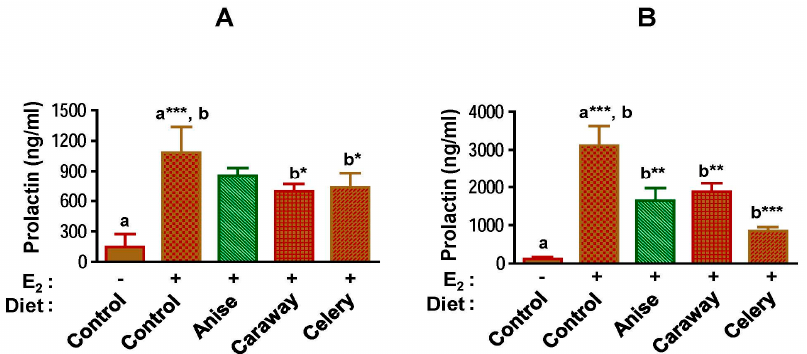
Figure 4. Spice diets reduce circulating prolactin levels in E2-treated ACI (August-Copenhagen Irish) rats. Prolactin levels were measured at 3 ( A ) and at 12 ( B ) weeks by enzyme immune-assay kit (Alpco Diagnostics, Windham, NH, USA) as per the manufacturer’s instructions. Average ± SD of five to six animals are shown. Symbols (– and +) denotes the absence and presence of E2, respectively. Alphabets (a and b) followed by asterisk shows statistical differences at * p < 0.05, ** p < 0.01, *** p < 0.001.